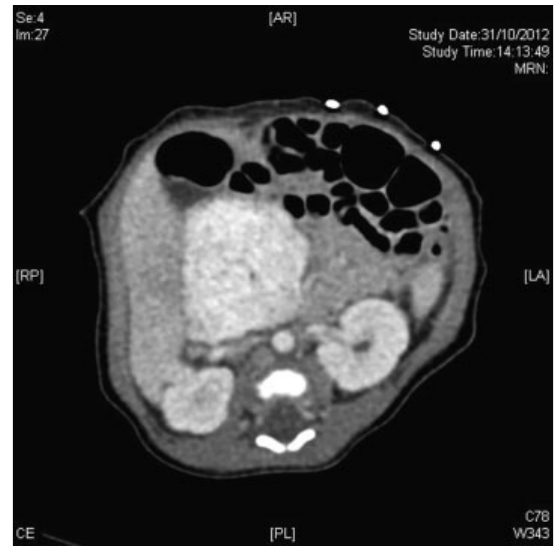
Fig. 2 Computed tomographic abdomen showing hypervascular mass.